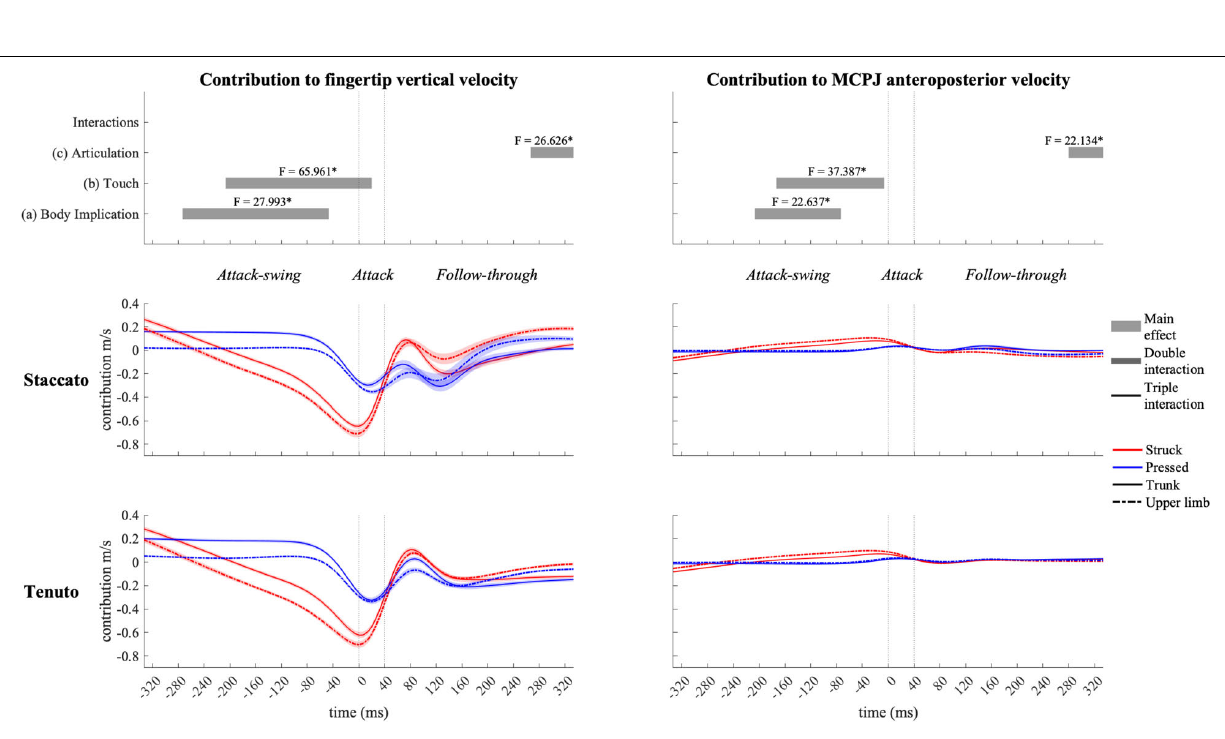
Frontiers in Psychology |